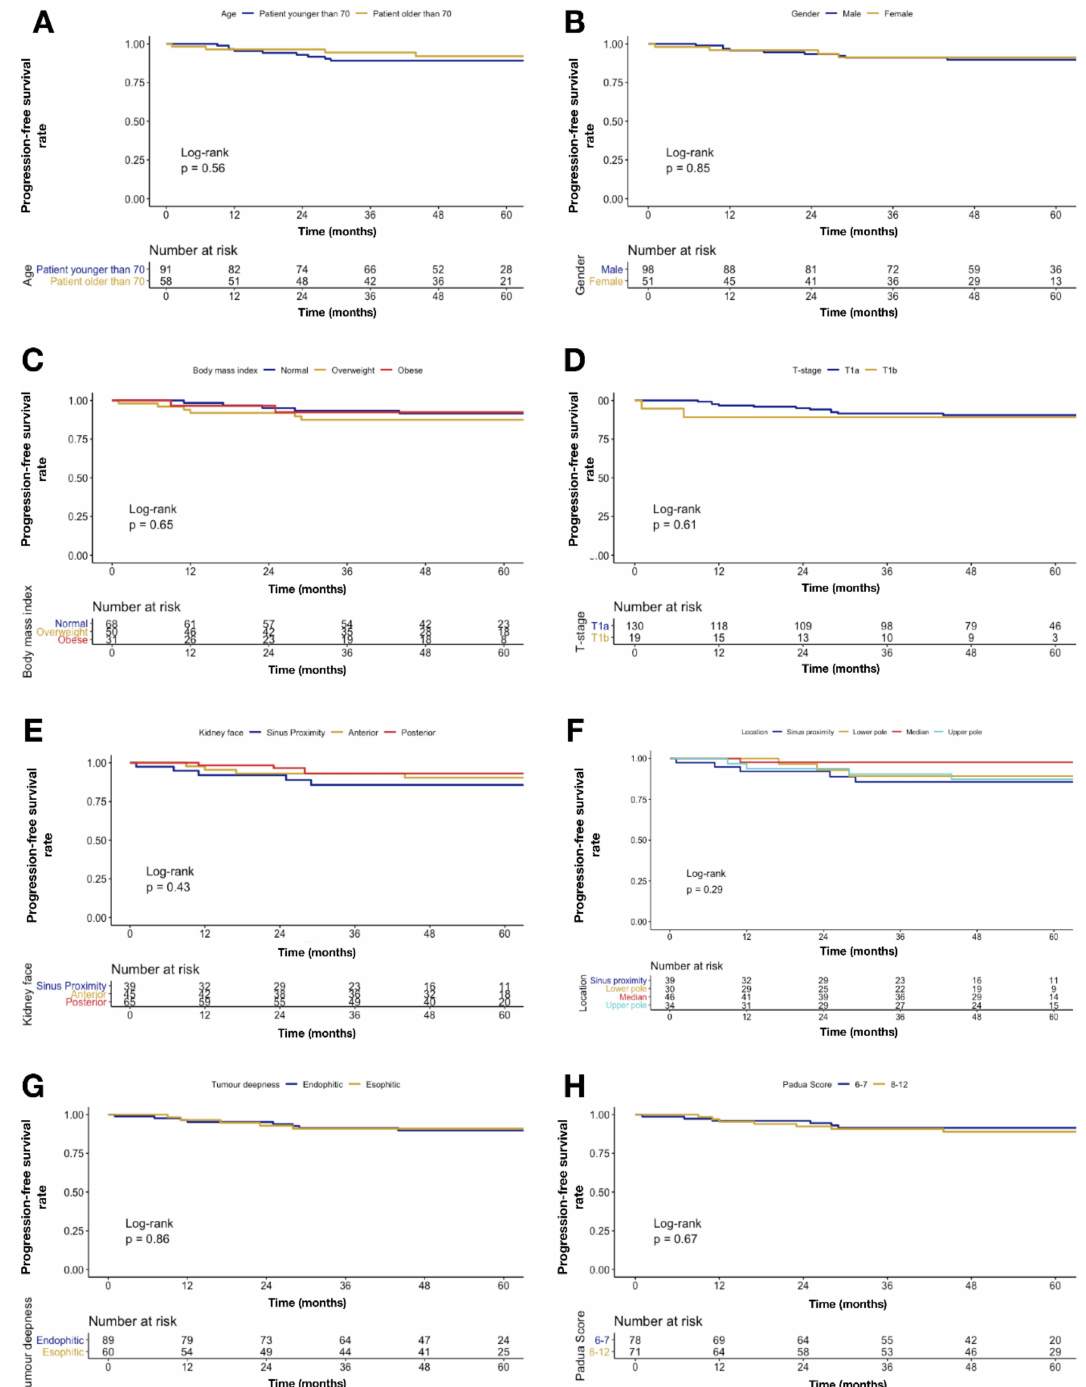
Figure 2. Kaplan–Meier plots depicting disease progression rate over time according to covariates: ( A ) age, ( B ) gender, ( C ) BMI, ( D ) T-stage, ( E ) renal face, ( F ) renal pole, ( G ) tumor deepness, and ( H ) PADUA